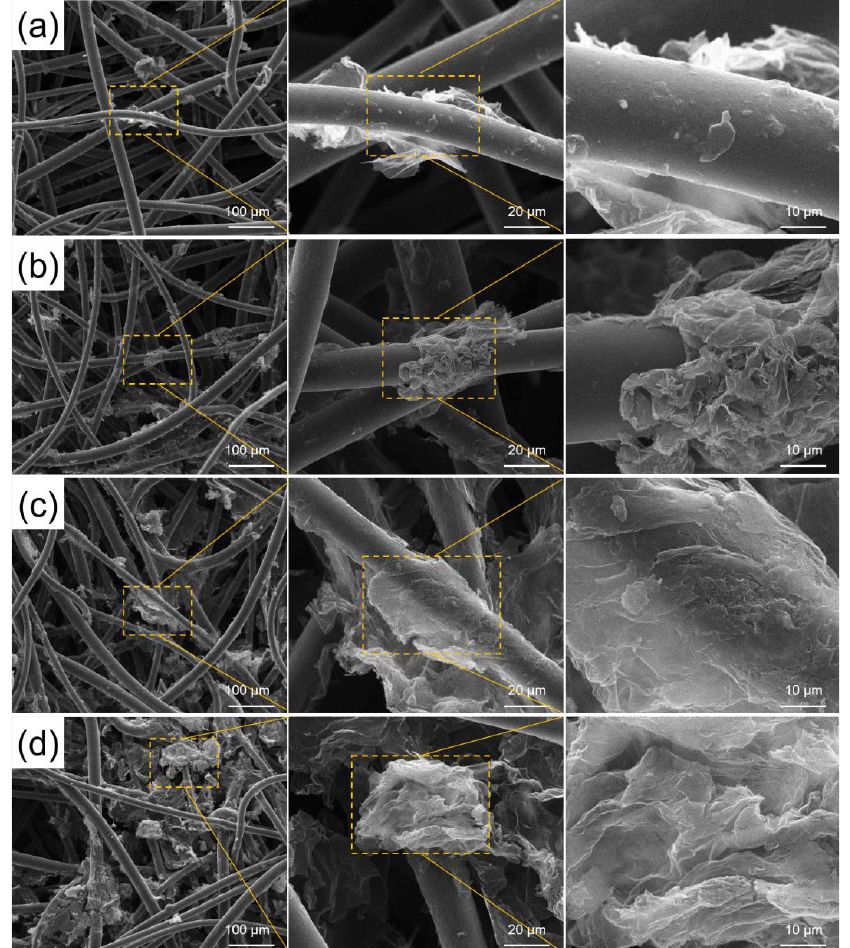
Figure 3. SEM of RGO/NW prepared by different GO solution concentrations: ( a ) 3 mg/mL; ( b ) 5 mg/mL; ( c ) 7 mg/mL; ( d ) 9 mg/mL.